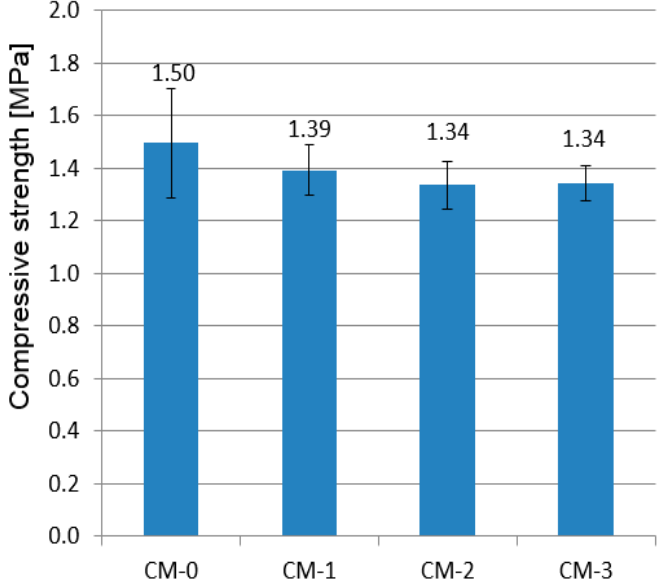
Figure 8. Flexural strength of tested mortars.